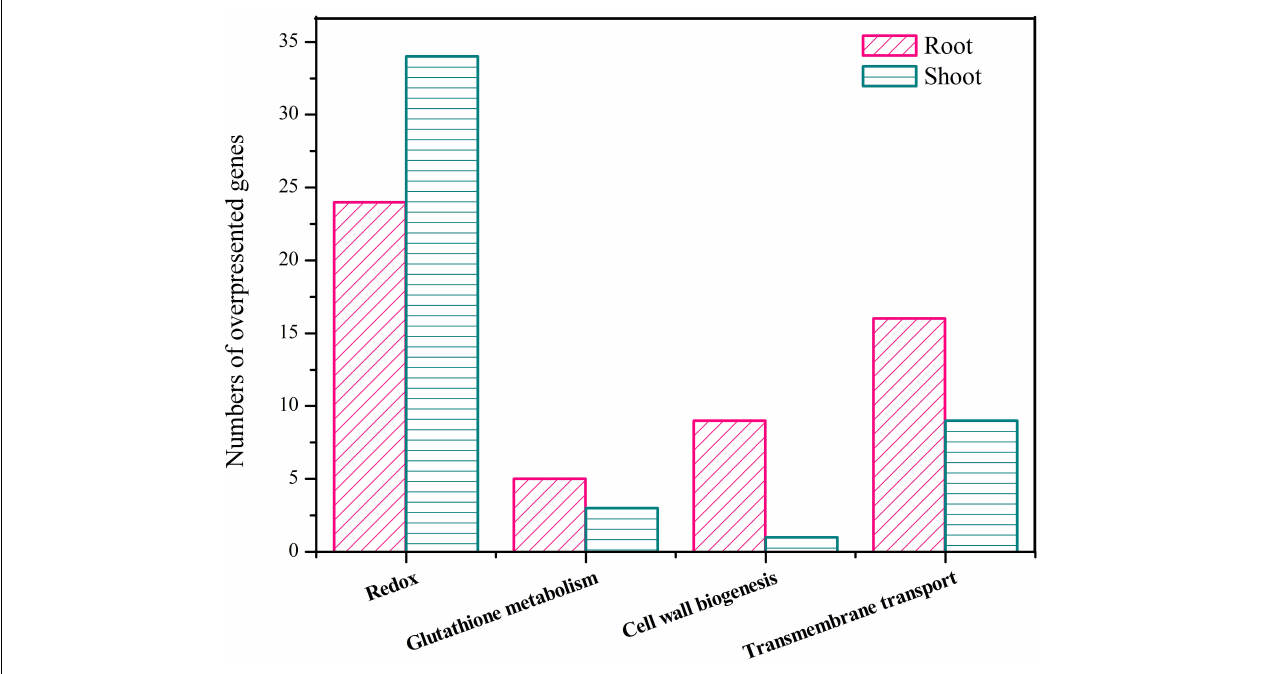
FIGURE 5 | Number of overexpressed genes participating in redox homeostasis, glutathione metabolism, cell wall biosynthesis, and transmembrane